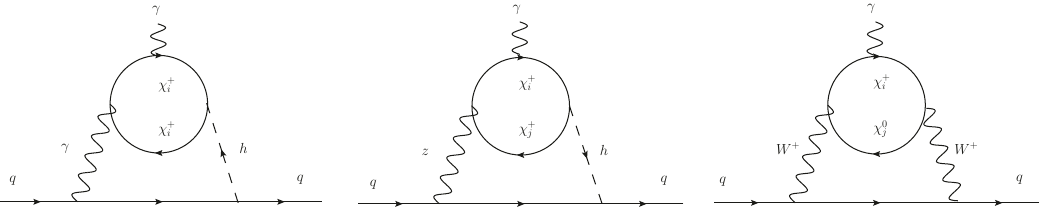
Figure 4 . The two-loop Barr-Zee type diagrams contributing to the quark EDM. The diagrams in which the photon or gluon is emitted from the W boson or the internal fermion do not contribute to the quark EDM or